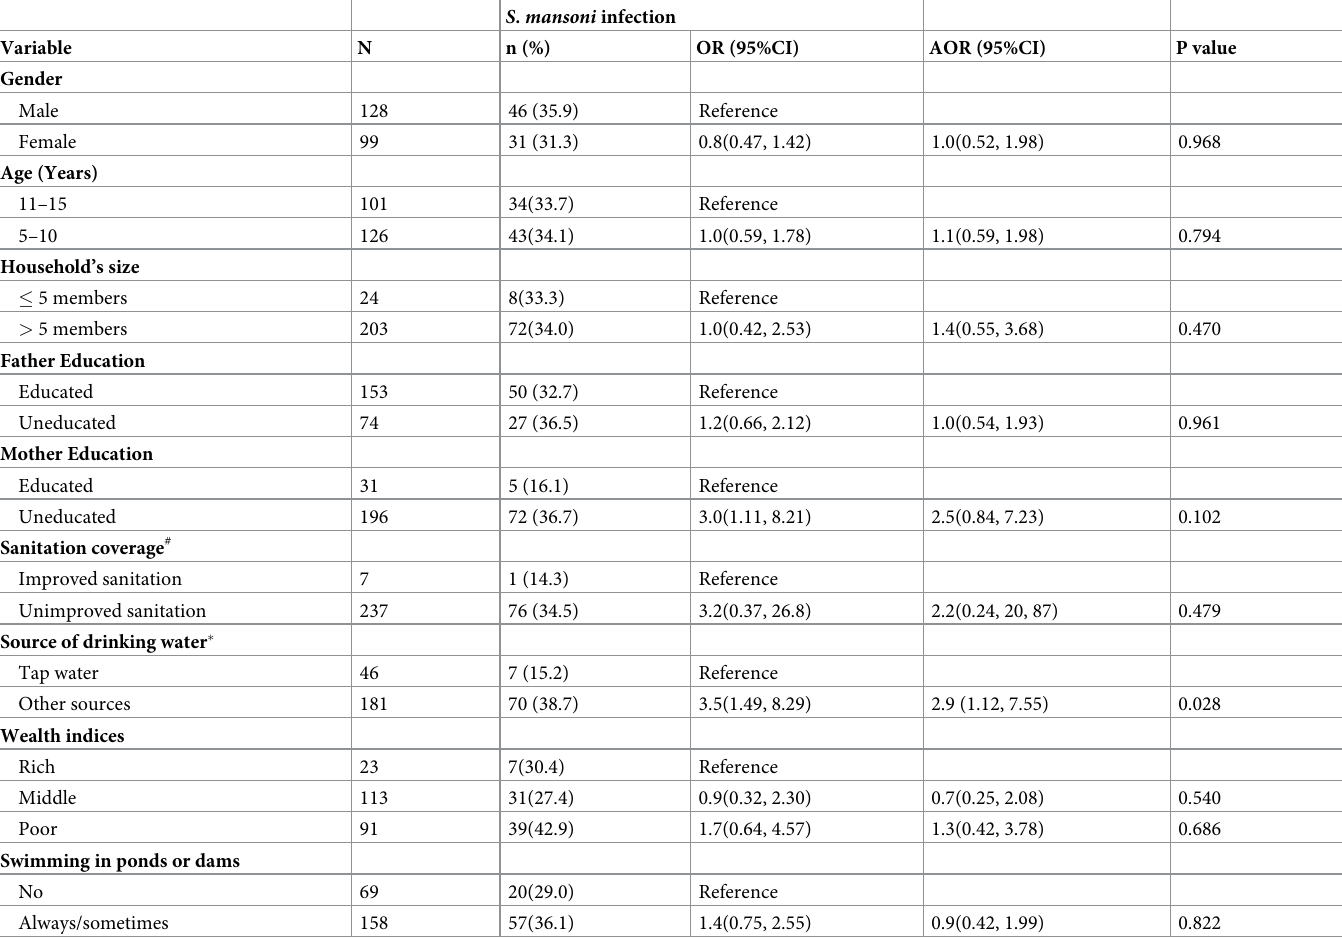
Table 3. Factors associated with Schistosoma mansoni among schoolchildren in Sana’a Governorate, Yemen (N = 227) & . S . mansoni